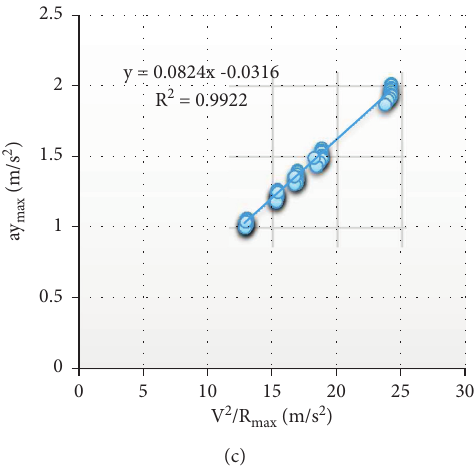
Figure 30: Maximum lateral acceleration in the simple horizontal curve. (a) Sedan. (b) SUV. (c) Truck.